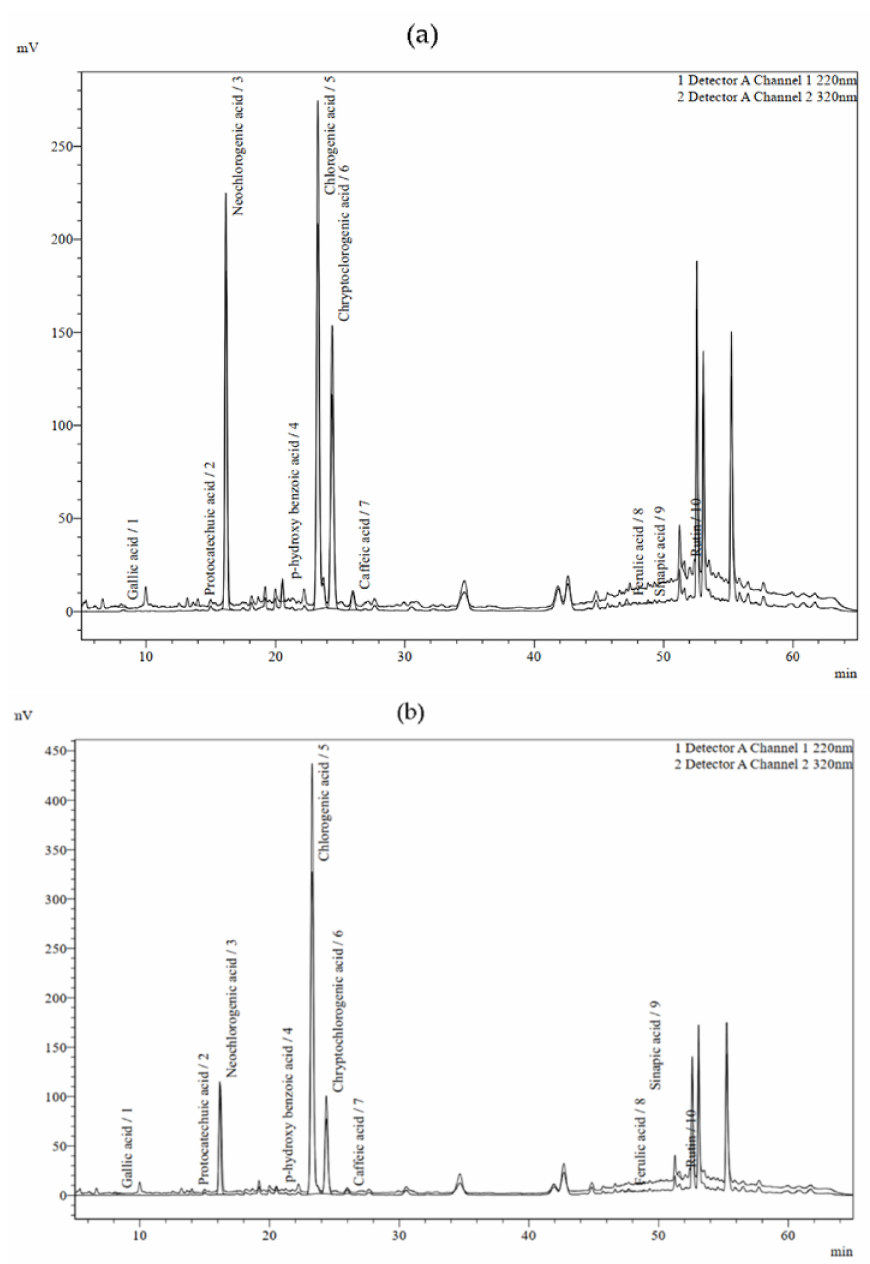
Figure 3. HPLC chromatogram of residual wastewater extracts after essential oil extraction by hydro-distillation ( a ) and microwave-assisted hydro-distillation ( b ). Peak assignment is given